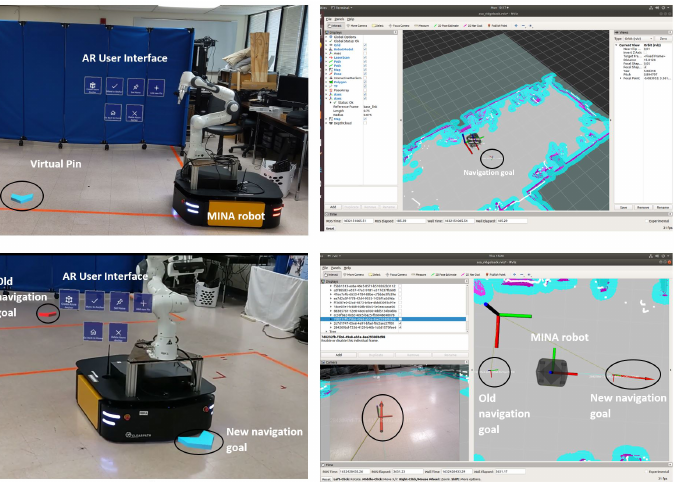
Figure 3. User interface: ( Top left ) The AR interface with 6 buttons to set navigation goals. A virtual pin is located in front of the robot. ( Top right ) The RViz rendering of the map and the navigation goal. ( Bottom left ) The MINA robot moving to a new navigation goal; the previous navigation goal is shown in red. ( Bottom right ) The RViz rendering of the map and navigation